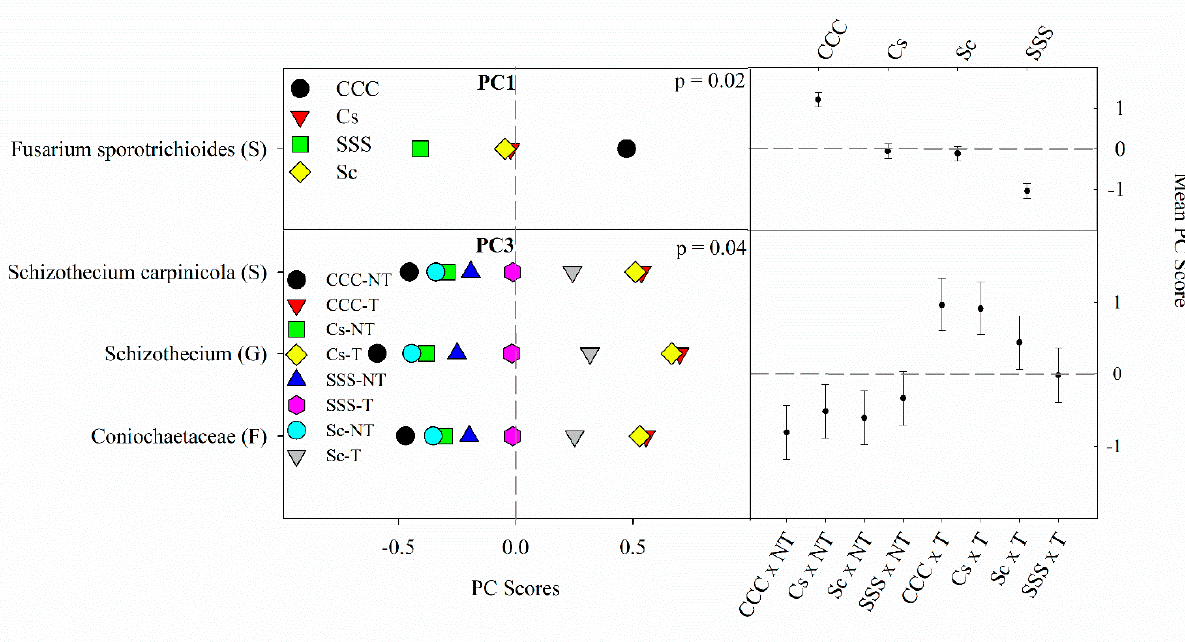
Figure 3. Mean fungal principal component scores (PC) following 20 years of rotation and tillage treatments. Right panels show the fungal mean PC score for the main effect of crop rotation for PC1 and the crop rotation × tillage interaction for PC3 based on the analysis of variance (ANOVA); error bars represent standard errors of the mean PC scores. Left panels show relative abundances (RAs) for each fungal indicator ASVs by crop rotation and crop rotation × tillage. The crop rotation main effects for PC1 are shown as CCC, continuous corn; Cs, corn phase of the corn-soybean rotation; Sc, soybean phase of the corn-soybean rotation; SSS, continuous soybean. The crop rotation × tillage interaction for PC3 is shown as CCC-NT, continuous corn and no-till; CCC-T, continuous corn, and chisel tillage; Cs-NT, corn phase of the corn-soybean rotation and no-till; Cs-T, corn phase of the corn-soybean rotation and chisel tillage; Sc-NT, soybean phase of the corn-soybean rotation and no-till; Sc-T, soybean phase of the corn-soybean rotation and chisel tillage; SSS-NT, continuous soybean and no-till; SSS-T, continuous soybean and chisel tillage. For each taxon, the response of each ASV was calculated as the mean PC score multiplied by the PC loading score of a given ASV. The y-axes show the name of the ASV’s most explanatory taxonomic rank in parentheses (P, phylum; C, class; O, order; F, family; G, genus; S, species).